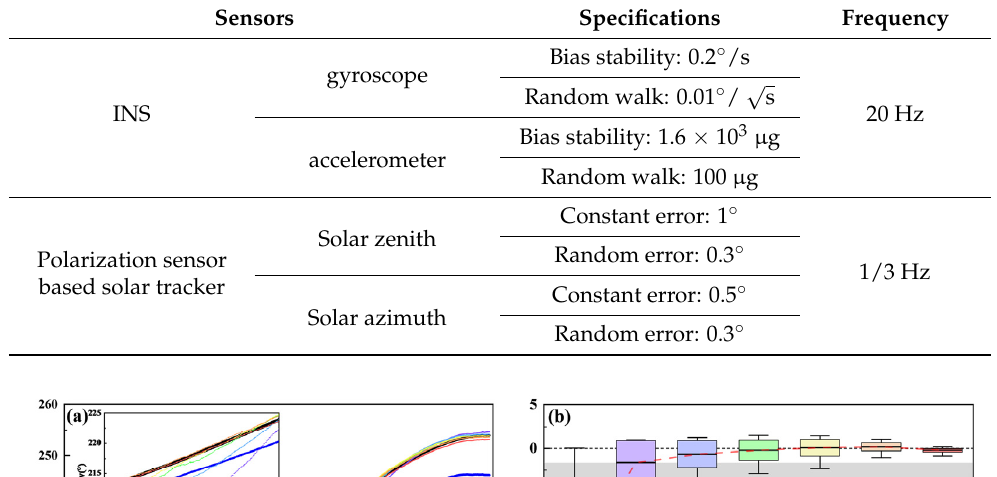
Table 5. Sensor parameters for simulation.